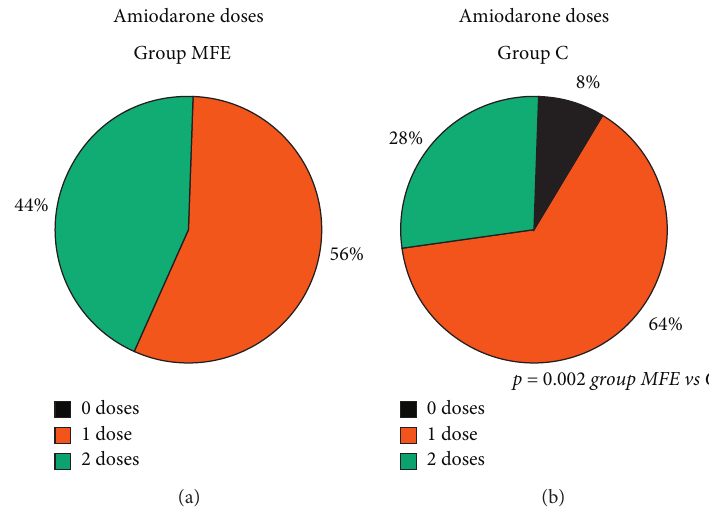
Figure 1: Number of amiodarone injections in both